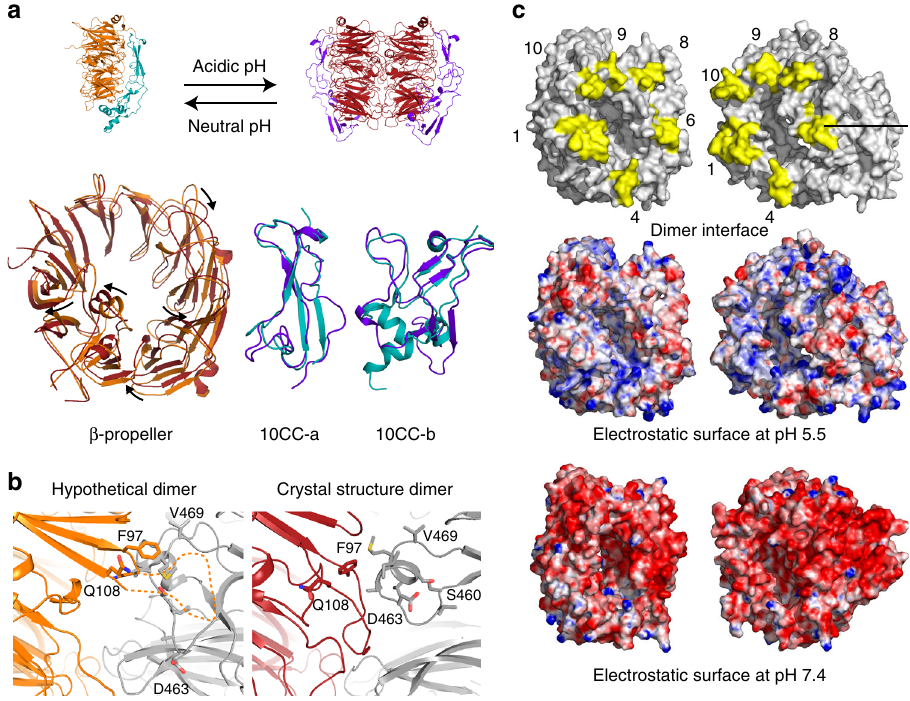
Fig. 2 A conformational change accompanies the monomer-dimer transition. a Cartoon representation of the dimer (red) and monomer (orange, PDB 3F6K) conformations. Superpositions of the monomer and dimer conformation of each domains reveal substantial conformational changes within the domains (bottom). b A conformational change is required to prevent steric clashes. Monomer s-sortilin conformation as hypothetical dimer leads to clashes predominantly arising from loop 97 – 108 (left panel). This loop is fl exible and not visible in the monomer mouse structure. It transitions to a structured form and provides interactions in the dimer (right panel). c Open book view of the dimer in surface representation (top) with the interface colored yellow. Blades involved in the dimerization are numbered. Below, gradient visualization from red ( − 10 kT/e) to blue (10 kT/e) of the electrostatic surfaces at pH 5.5 and 7.4, calculated with the APBS server 53, 54 based on residue pKa determined by PROPKA